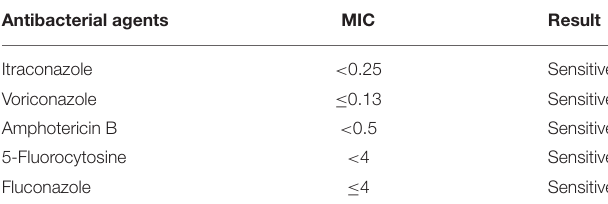
TABLE 1 | Drug susceptibility results of Cryptococcus neoformans .